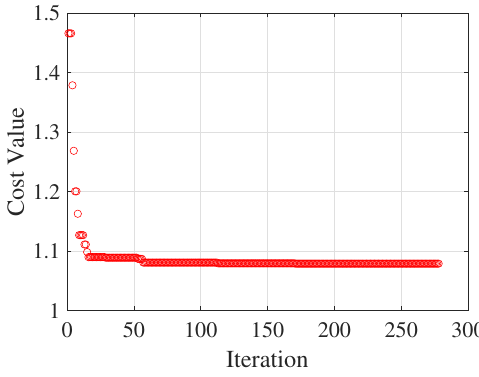
Figure 9. The best values of cost function in case 2.